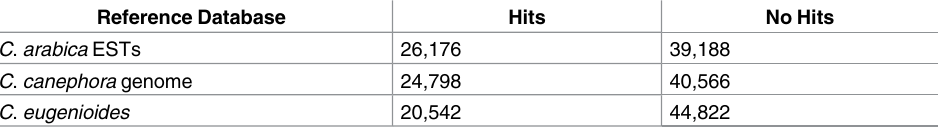
Table 2. Similarity analysis of coffee and plant database